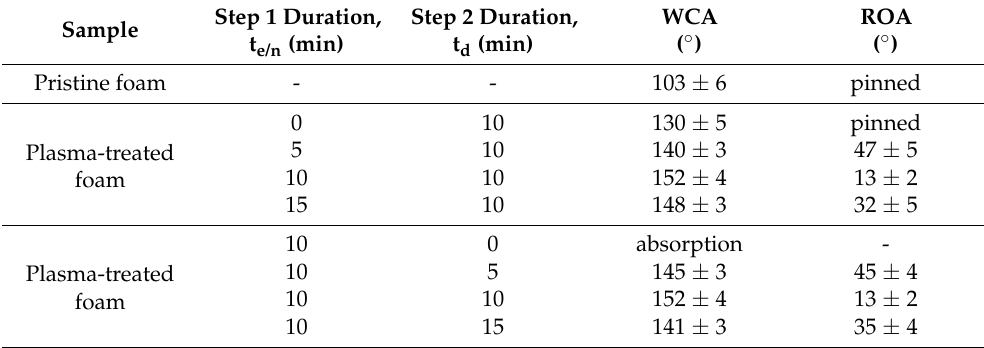
Table 3. Water contact angle (WCA) and roll-off angle (ROA) of the PU foam before and after the two-step plasma process with different durations of each step (0, 5, 10, 15 min). Step 1 Sample